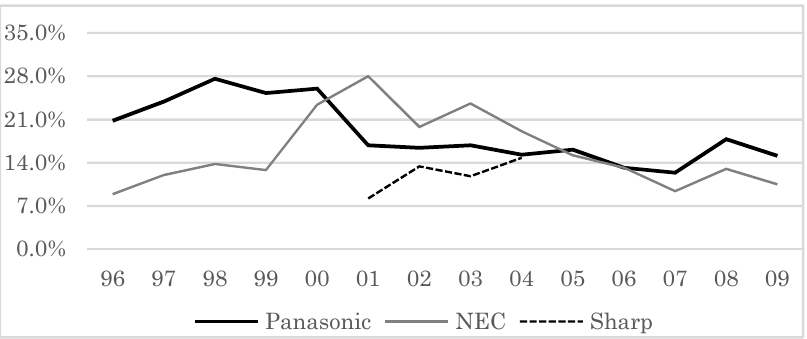
Figure 8. The transition of market